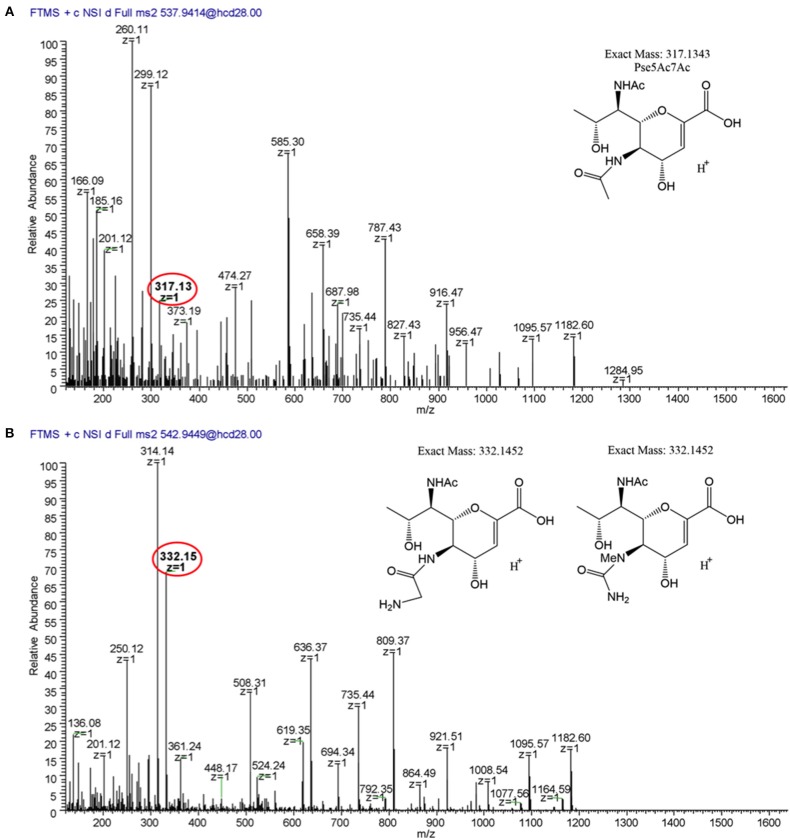
LC/MS-MS fragmentation spectra of trypsin-digested C. jejuni 12661 flagellar glycopeptide 180ISSSGEVQFTLK191. (A) MS2 spectrum of 180ISSSGEVQFTLK191 + a glycan of oxonium ion m/z = 317.13 (C13H21O7N2+), (B) MS2 spectrum of 180ISSSGEVQFTLK191 + a glycan of oxonium ion m/z = 332.15 (C13H22O7N3+). Oxonium ions are circled, and proposed structures of monosaccharides are shown.